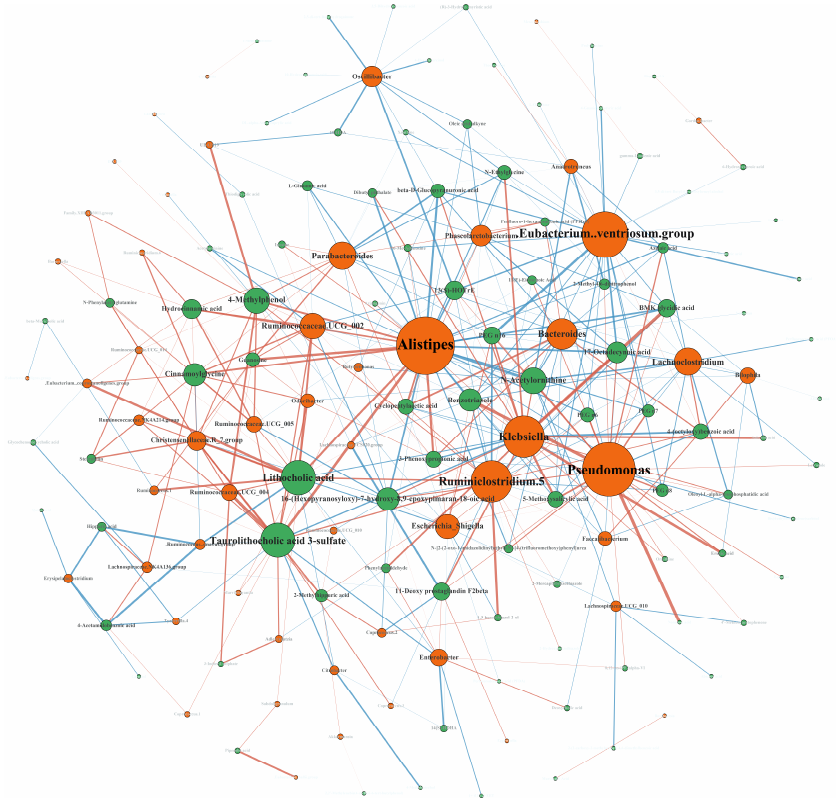
Figure 4. Correlation network of microbiome and metabolome. Correlation is represented by the connecting lines. A red connecting line represents a positive correlation between nodes, and a blue line represents a negative correlation. The size of a node is proportional to the number of lines it is connected to.